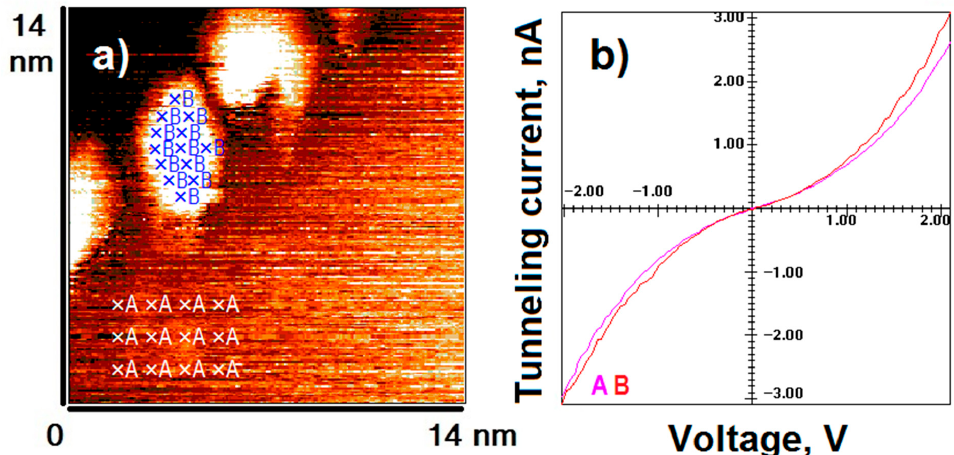
Figure 1. Surface of HOPG with deposited gold nanoparticles: ( a ) topography image, ( b ) VAC of nanoparticles and HOPG before exposure to hydrogen.